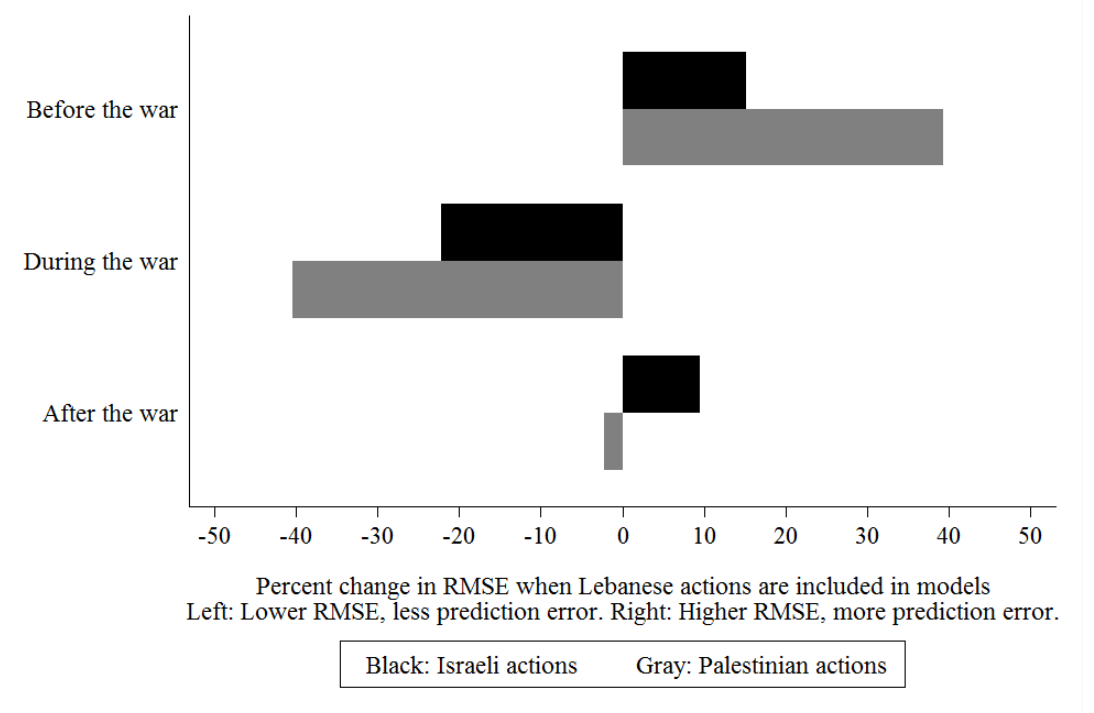
Figure 5: Actor Shock: Prediction Errors With a New Actor. Legend: Including Lebanese events reduces prediction error considerably during the 2006 Israeli-Hizbullah war, but not just before and after the war.